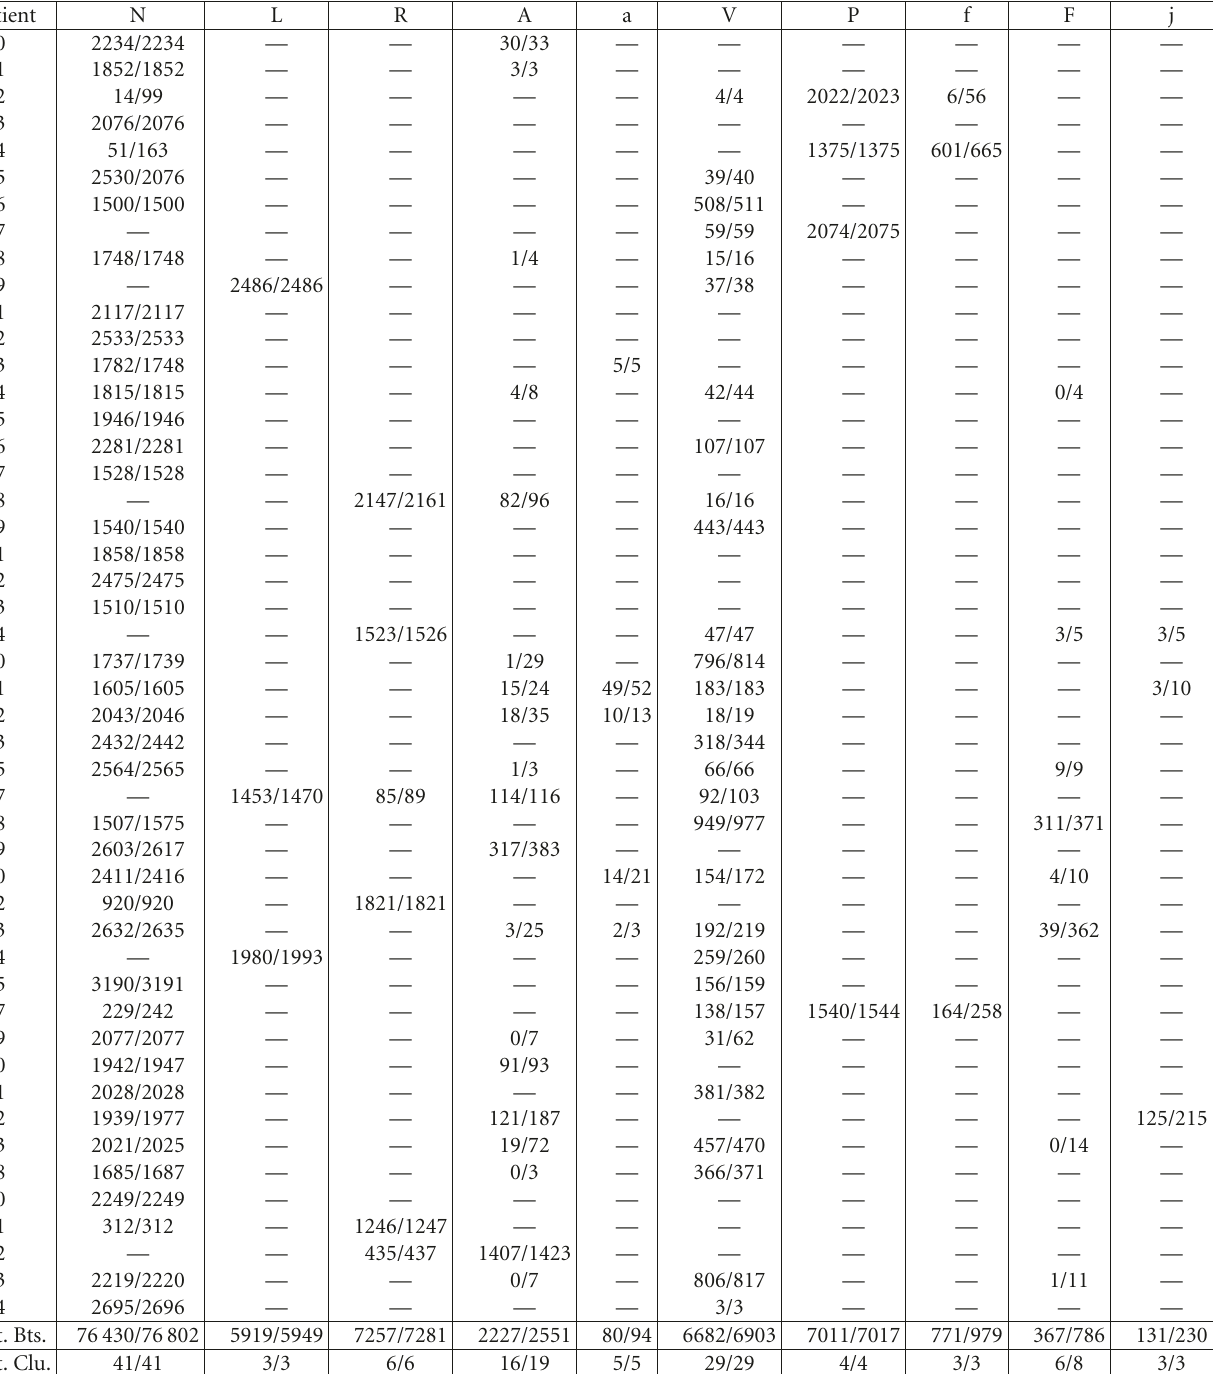
Table 4: Beats detected for each patient in the MIT-BIT arrhythmia database using symbolization. The error in this case is similar to that reported in Table 1, with an overall error once again of 1.37%. The labels are identical to those in Table 2.